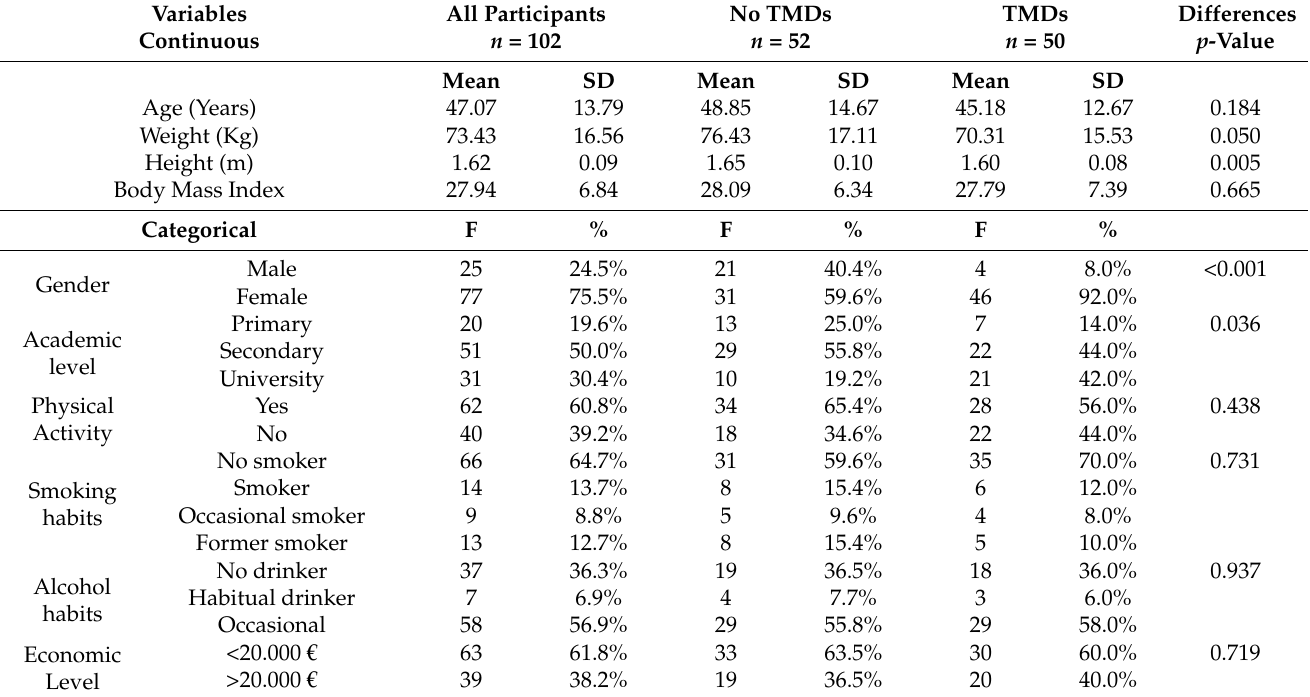
Figure 1. Flow diagram of the participants. Table 1. Sociodemographic variables.